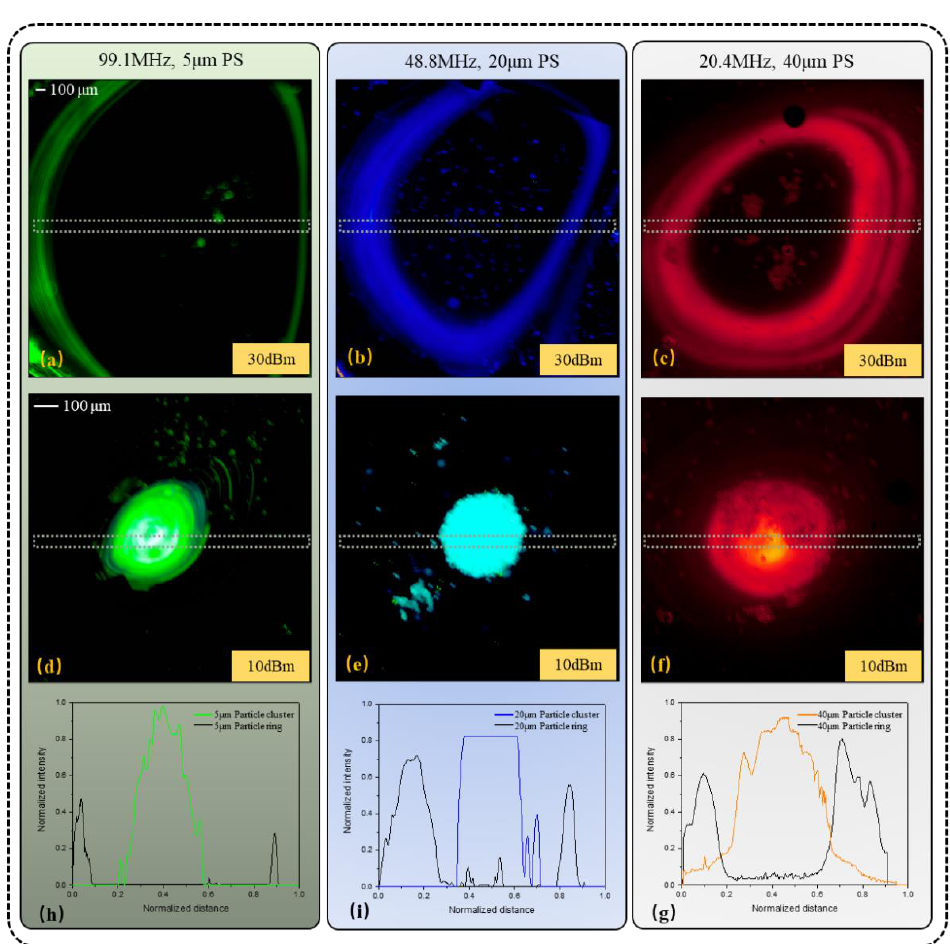
Figure 5. Summary of the experimental manipulation of different diameter (5, 20, and 40 μm) polystyrene (PS) particles suspended in DI water using TSAWs of different frequencies (90.1, 48.8, and 20.4 MHz). Screenshots of the sessile droplets loaded with particles were captured after the SAW was exposed at 30 dBm ( a – c ) and 10 dBm ( d – f ) RF power for periods sufficiently long to attain the desired particle concentrations at the target locations. The normalized fluorescence intensities (NFI) values measured from the droplet centers (see the dashed rectangles in ( a – f ), from left to right) are plotted in ( h – g ) to characterize the migration characteristics of the particles at different signal intensities.